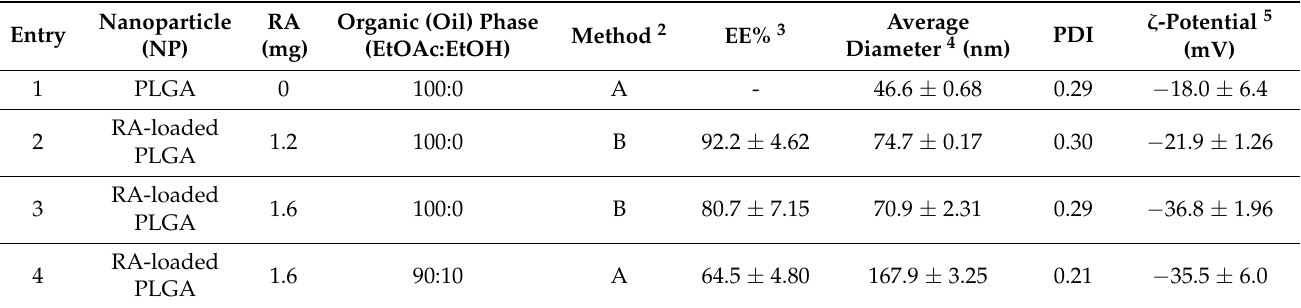
Table 1. Biophysical characterization of PLGA and RA@PLGA polymeric NPs 1